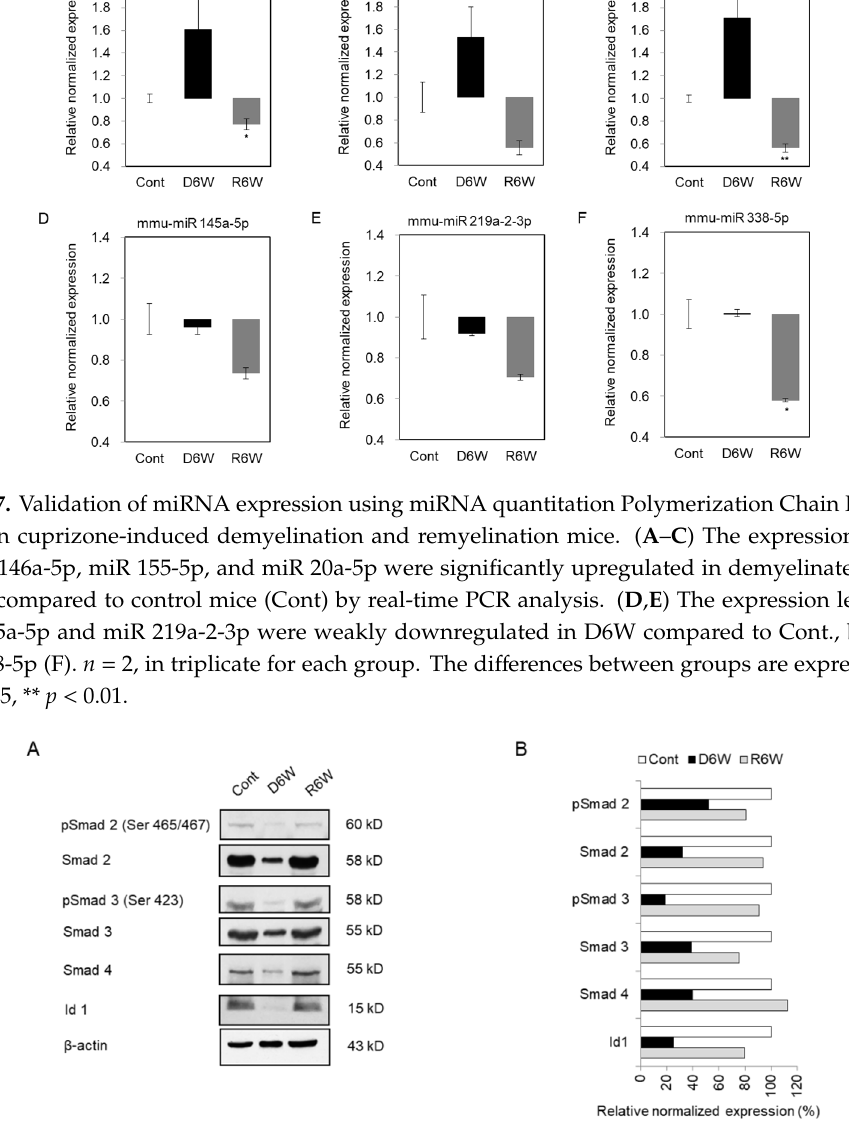
Figure 9. The proposed mechanism of miR 155-5p and miR 20a-5p upregulations led to demyelination. ( A ) The illustration shows a proposed mechanism in normal diet-fed, healthy mice. ( B ) The illustration shows that the proposed mechanism of miR 155-5p and miR 20a-5p upregulations led to demyelination in 0.2% cuprizone diet-fed mice. 3. Discussion The disruption of the myelin sheath of CNS is a prominent phenomenon of many clinically relevant disorders on the basis of physiopathology [36]. Several mouse models are available for studying demyelination and remyelination. The best-characterized demyelinating mouse model is the C57BL/6J with 0.2% CPZ added to the diet [24]. Several hypotheses have been proposed [17,24,37], but it is still unclear why CPZ, a copper chelator molecule, specifically affects oligodendrocytes, the cell type that synthesizes and maintains the CNS myelin sheath. The behavior of CPZ-fed mice has not been sufficiently studied [17,37,38]. Morell et al. (1998) reported that CPZ-treated animals did not appear to be as active at the end of the first week of CPZ administration, and also during the following several weeks of CPZ exposure. The same authors reported that, during the recovery period, the animals displayed normal activity levels, and were